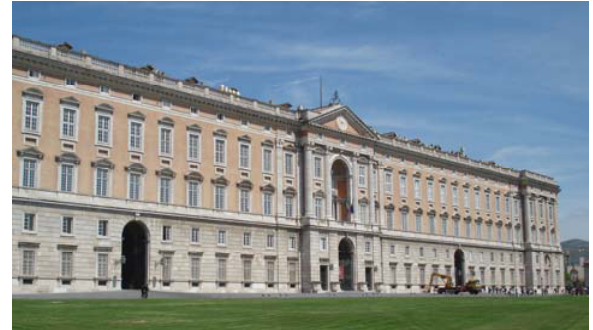
Figure 2. Façade of the Royal Palace in